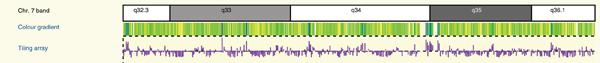
Advanced stylesheets. Examples of advanced rendering techniques possible with DAS: colour gradients and tiling arrays, as displayed in Ensembl.